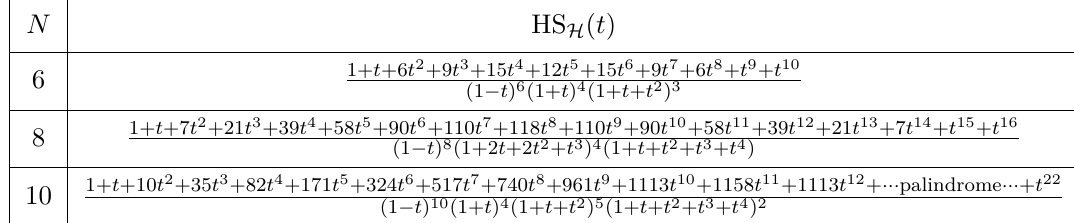
Table 2 . Higgs branch Hilbert series of (3.6) and (3.18) for N v = 1 and various values of N .